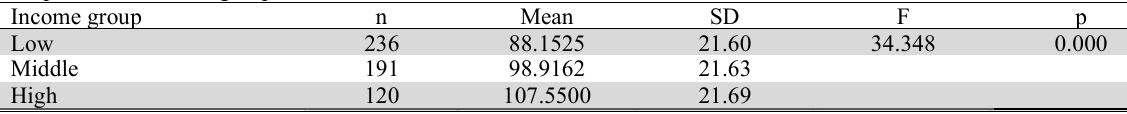
Comparison of income group for